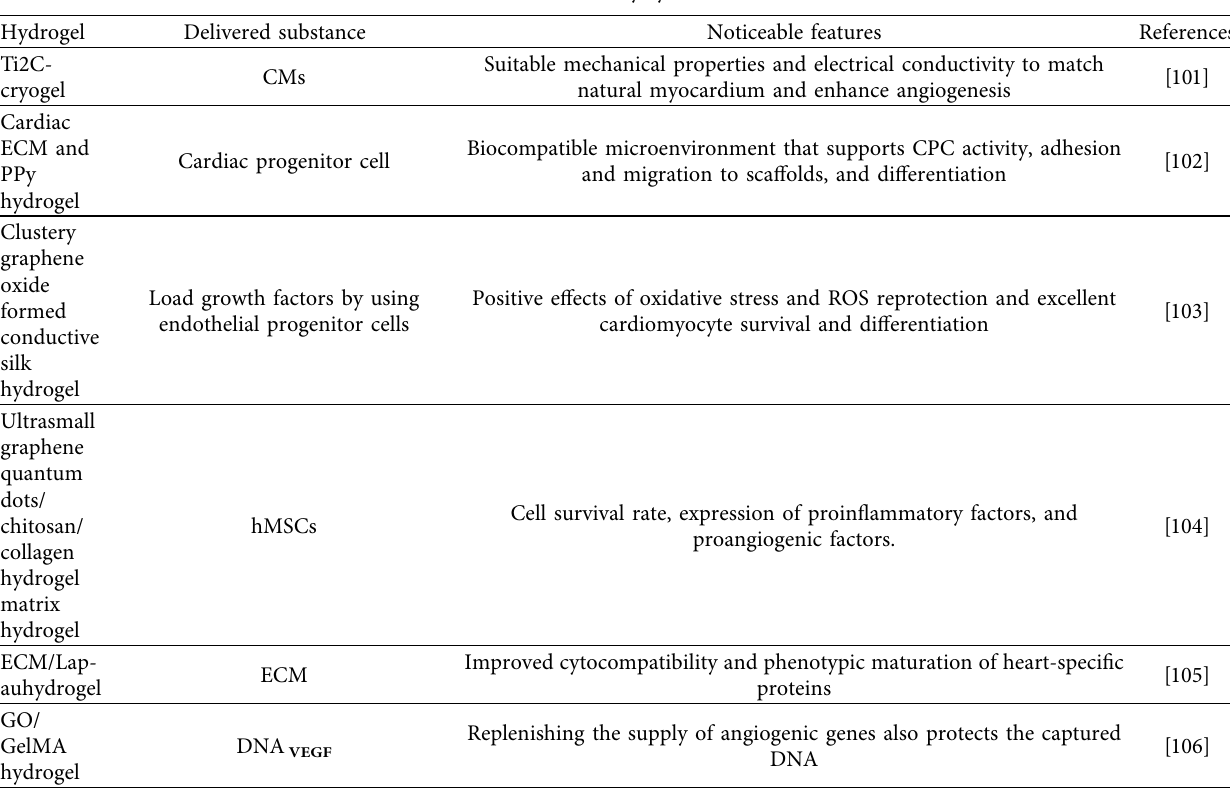
Table 4: EHs for delivery systems to treat